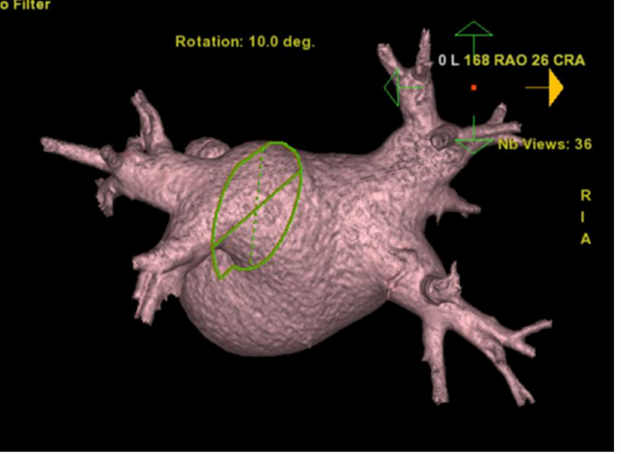
Figure 12. Computed tomography: 3-D reconstruction of the left atrium along with the four pul- monary